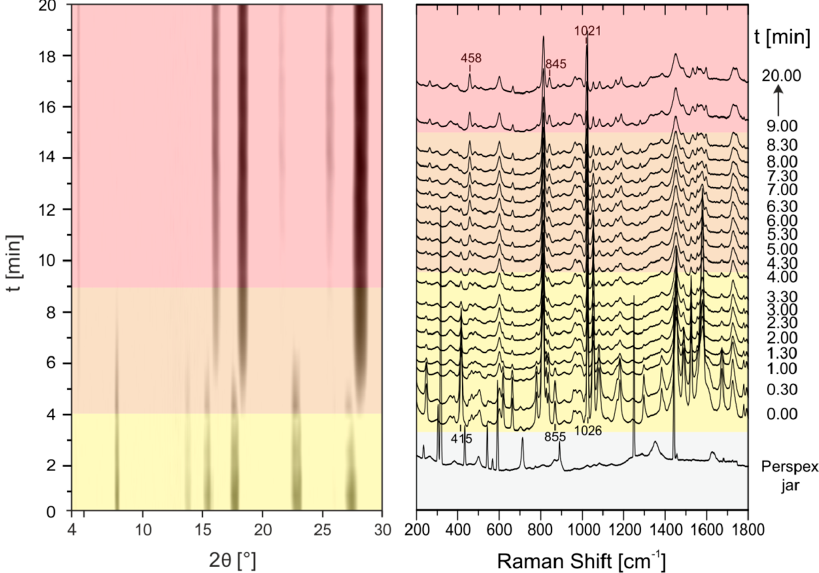
Figure 5. Time resolved investigation of the synthesis process of the PZA:OA (1:1) cocrystal obtained by neat grinding of PZA with oxalic acid anhydrous followed in situ by synchrotron XRD ( left ) and Raman spectroscopy ( right ). The Raman spectrum of the empty Perspex jar (gray) indicates which modes of the following synthesis process arise from the sample holder and which from the reaction mixture. Yellow: reactants; orange: reactants and product; red: product.